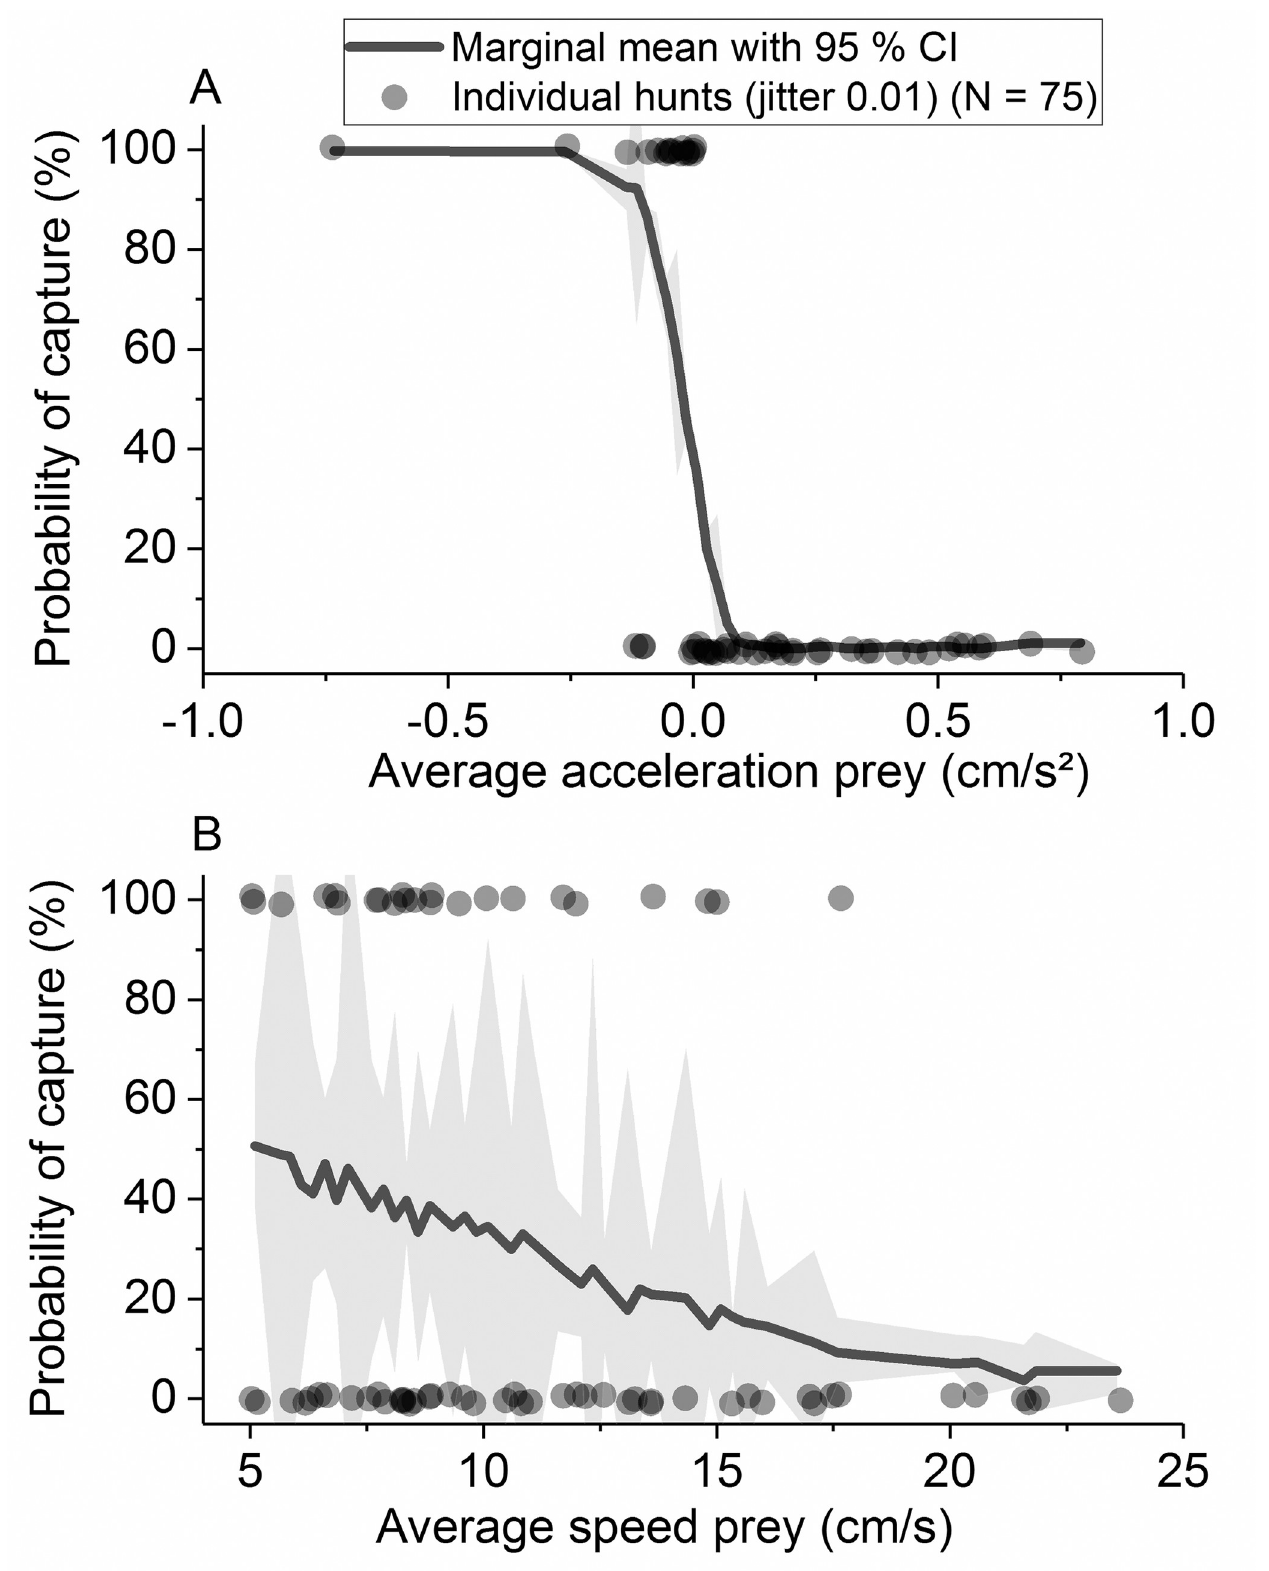
Fig 8. Likelihood to capture prey. Output of the multivariate logistic regression depicted the likelihood of the predator to capture the prey in relation to A) the average acceleration of the prey and B) the average speed of the prey, N = 75 predation events, including all prey species and outcomes. https://doi.org/10.1371/journal.pone.0256427.g008 PLOS ONE | https://doi.org/10.1371/journal.pone.0256427 August 26,